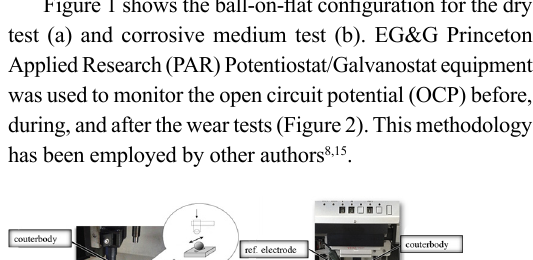
Figure 3: Microstructure of martensitic stainless steel DIN 1.4110 in the as received condition.